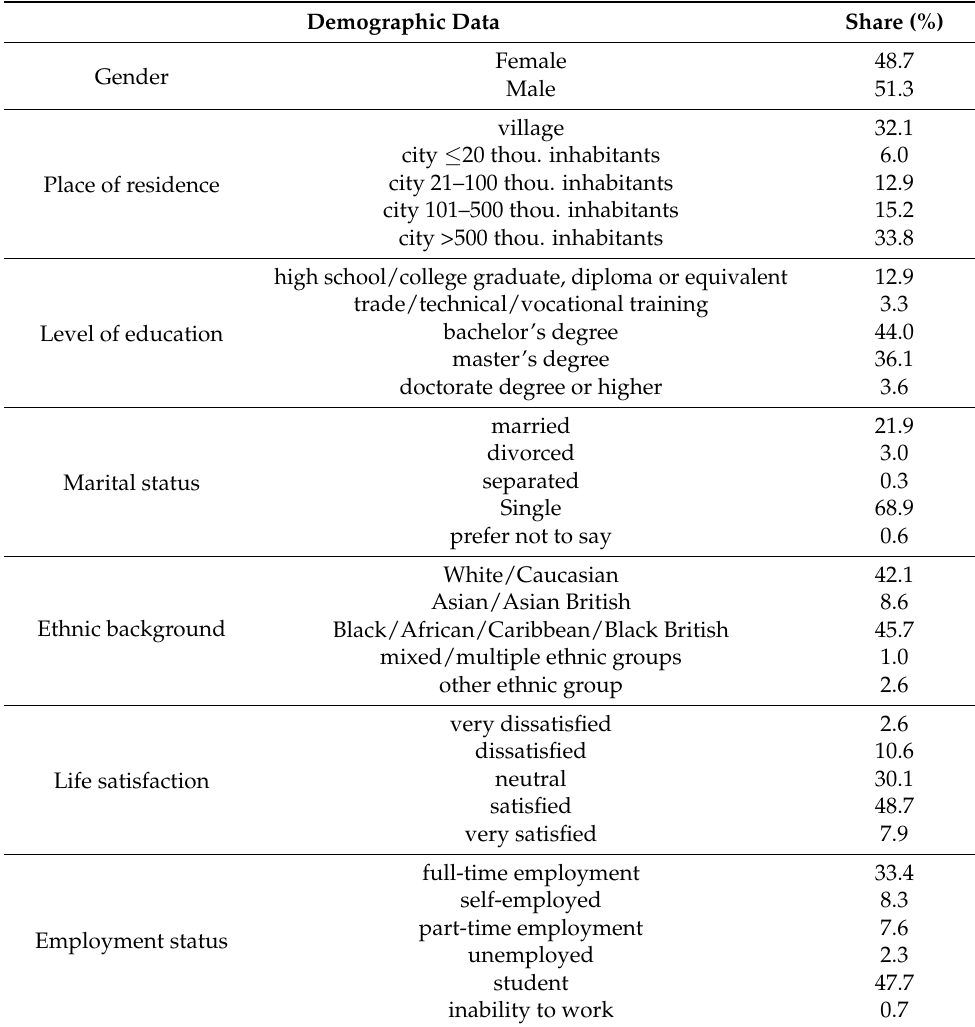
Table 1. Social characteristics of the respondents on the background of demographic data: fraction of the respondents (share